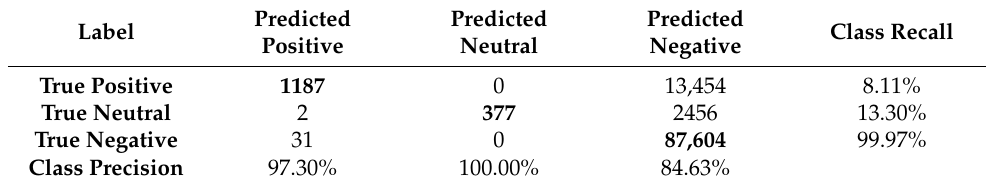
Table 8. The Confusion Matrix and other metrics from the training dataset using the model.